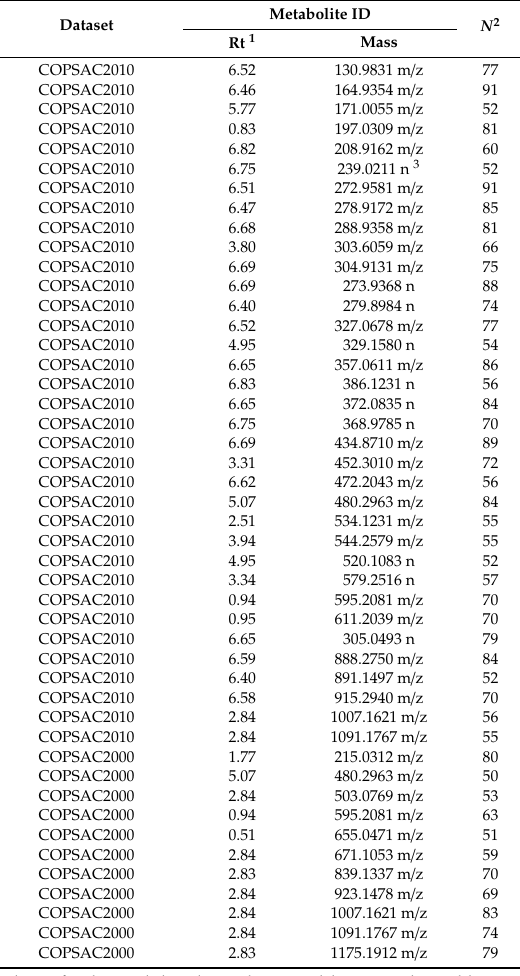
Table 4. Variable selected by stability